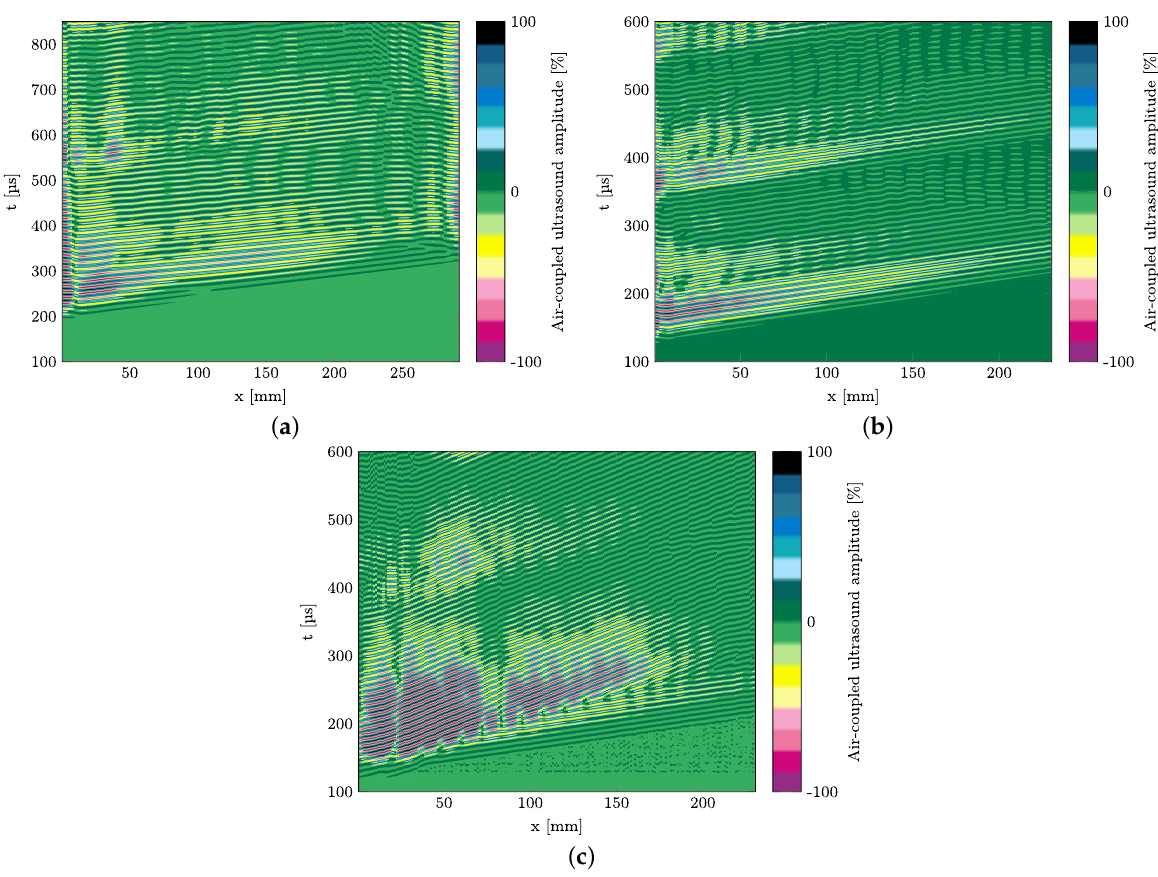
Figure 10. Experimentally determined B−scan of the GFRP strip specimen along the measurement path from actuator to polyimide inlay. Generated using air−coupled ultrasound technique. The polyimide inlay starts at x = 100mm, cf. Figure 2. The measurement with inclined probe shows two modes while the experiment with a perpendicular probe only reveals one mode which is due to the different sensitivities for in−plane and out−of−plane components and the different occurring displacement fields. ( a ) 75kHz with perpendicular probe. ( b ) 120kHz with perpendicular probe. ( c ) 120kHz with probe under an angle of